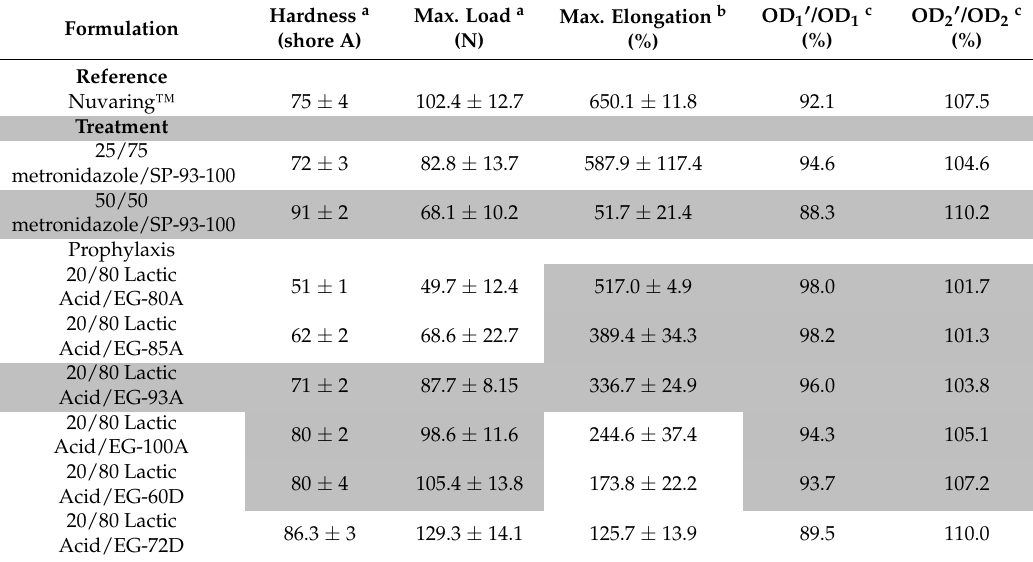
Table 3. Overview of intravaginal ring properties (mean ± SD, n = 3). Devices that featured similar mechanical properties to reference were highlighted in grey. Adapted from [15], Elsevier, 2017 with